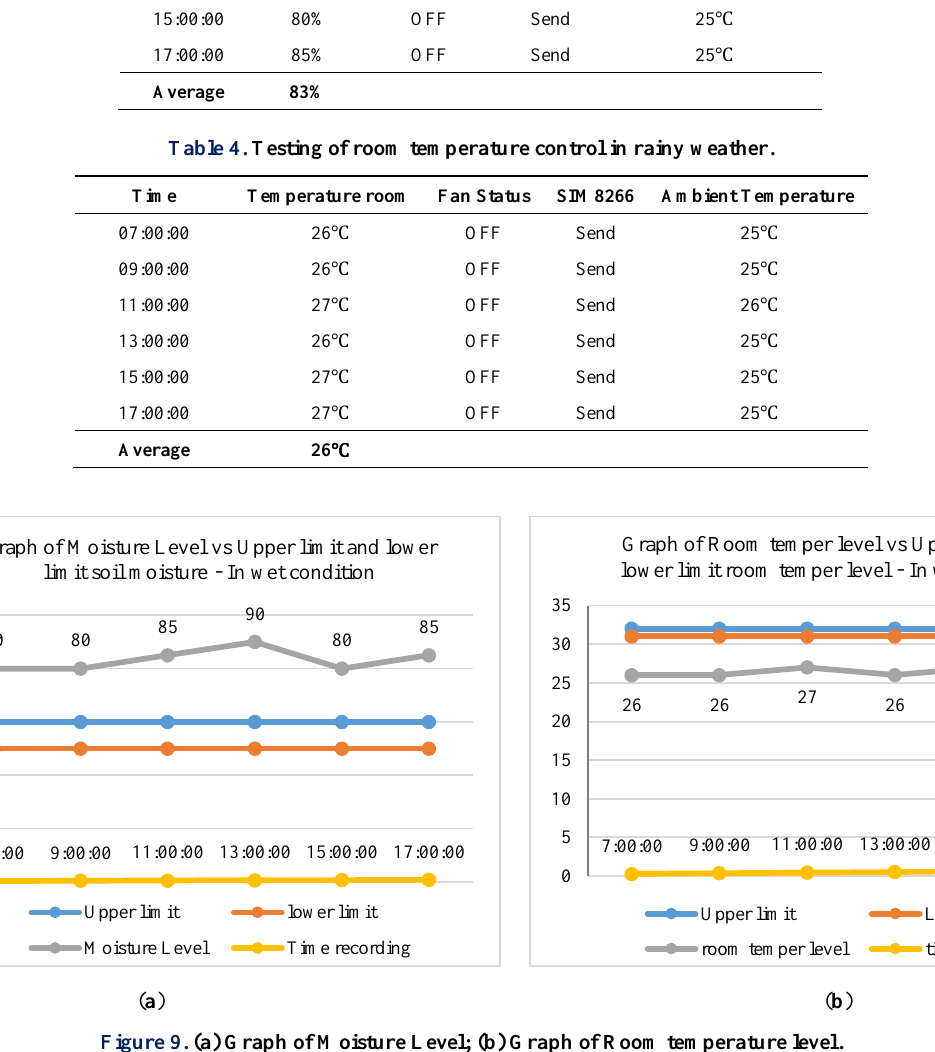
Figure 9. (a) Graph of Moisture Level; (b) Graph of Room temperature